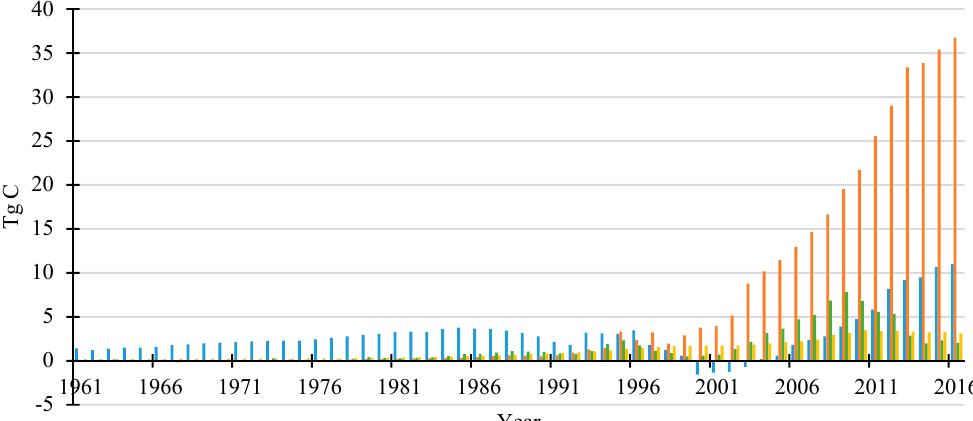
Figure 2. Annual change of carbon stored in HWP in china by different categories.